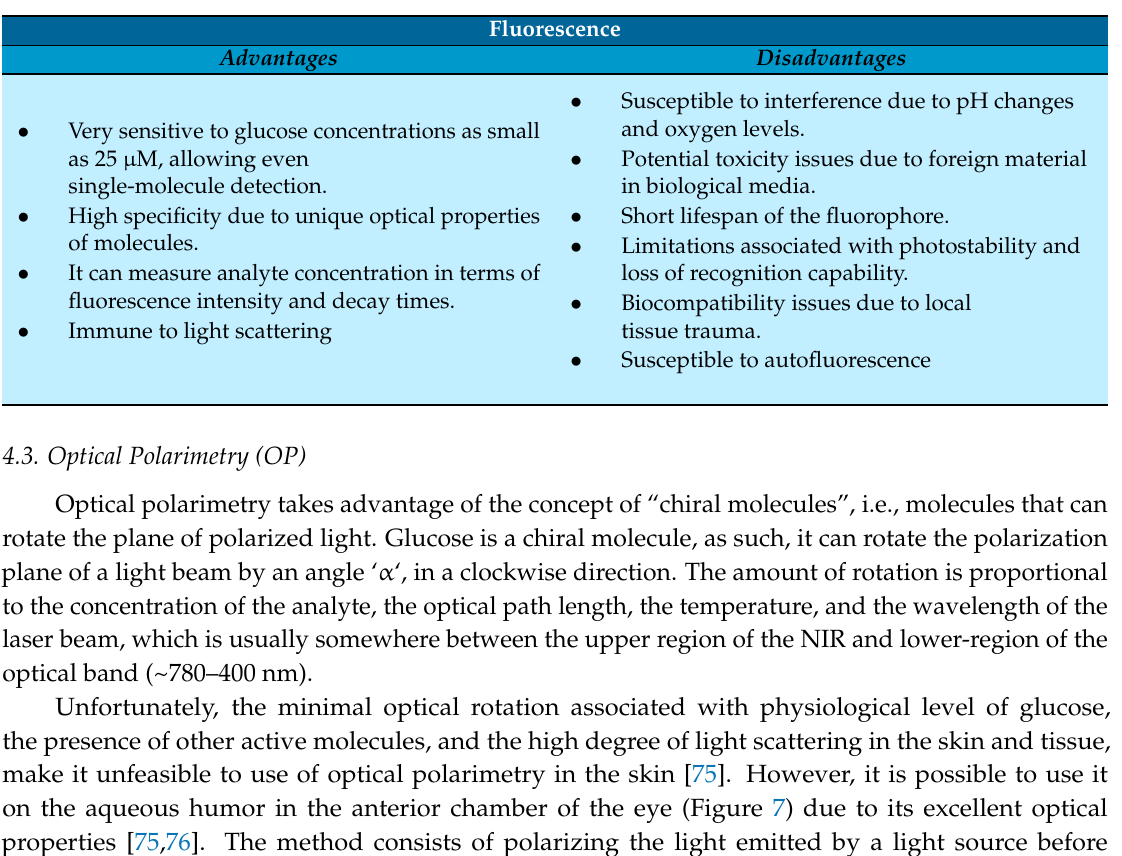
Table 6. Advantages and disadvantages of fluorescence technology.